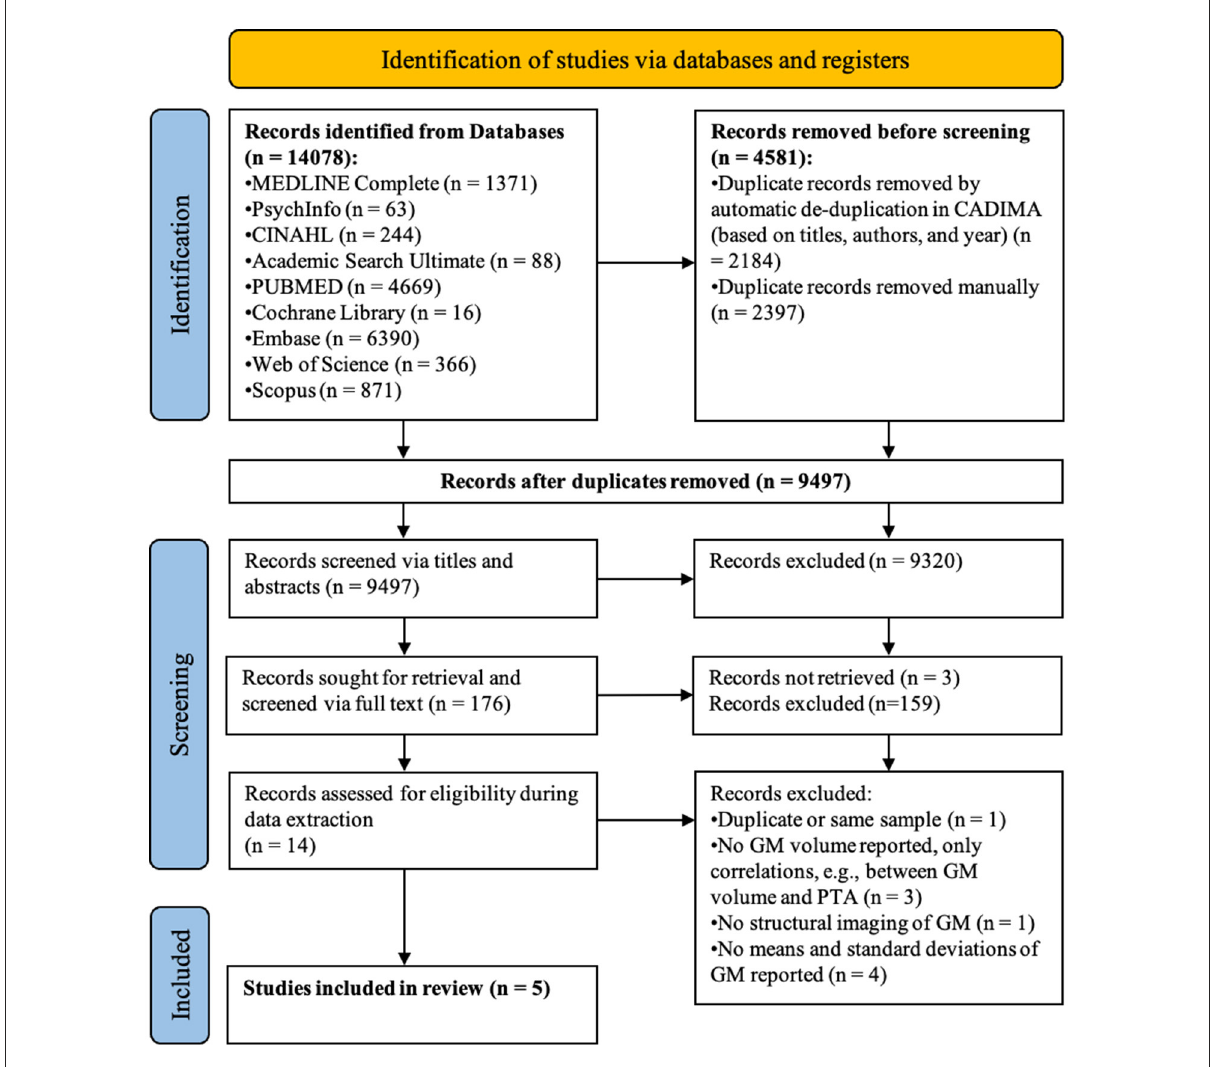
FIGURE1 PRISMA flow diagram detailing the number of articles selected at each review stage. GM refers to gray